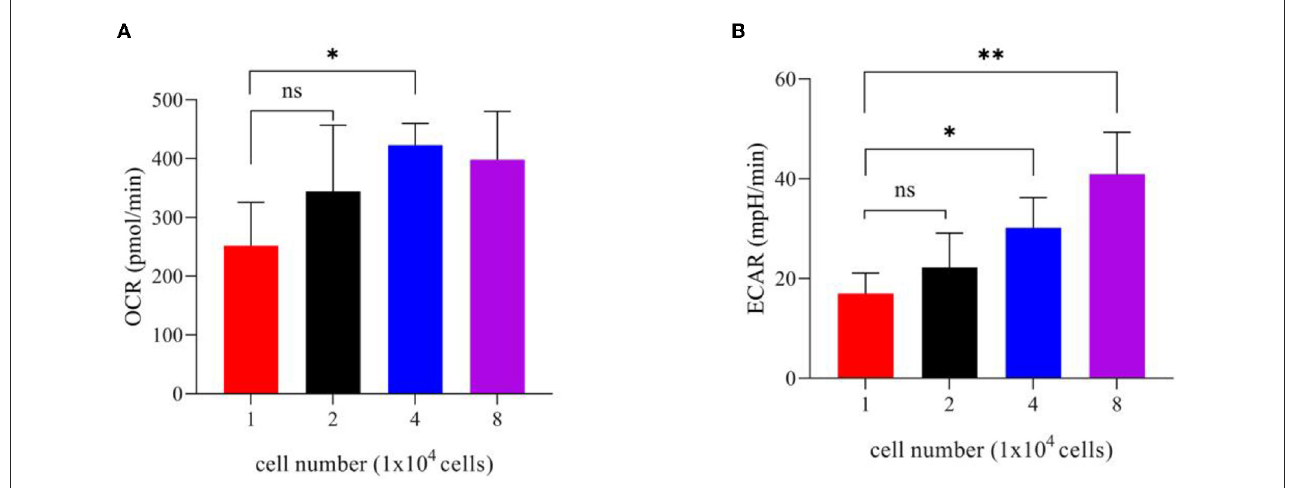
FIGURE4 Bar chart of different cell numbers. (A) OCR values of different cell numbers. (B) ECAR values of different cell numbers. * P < 0.05 and ** P <